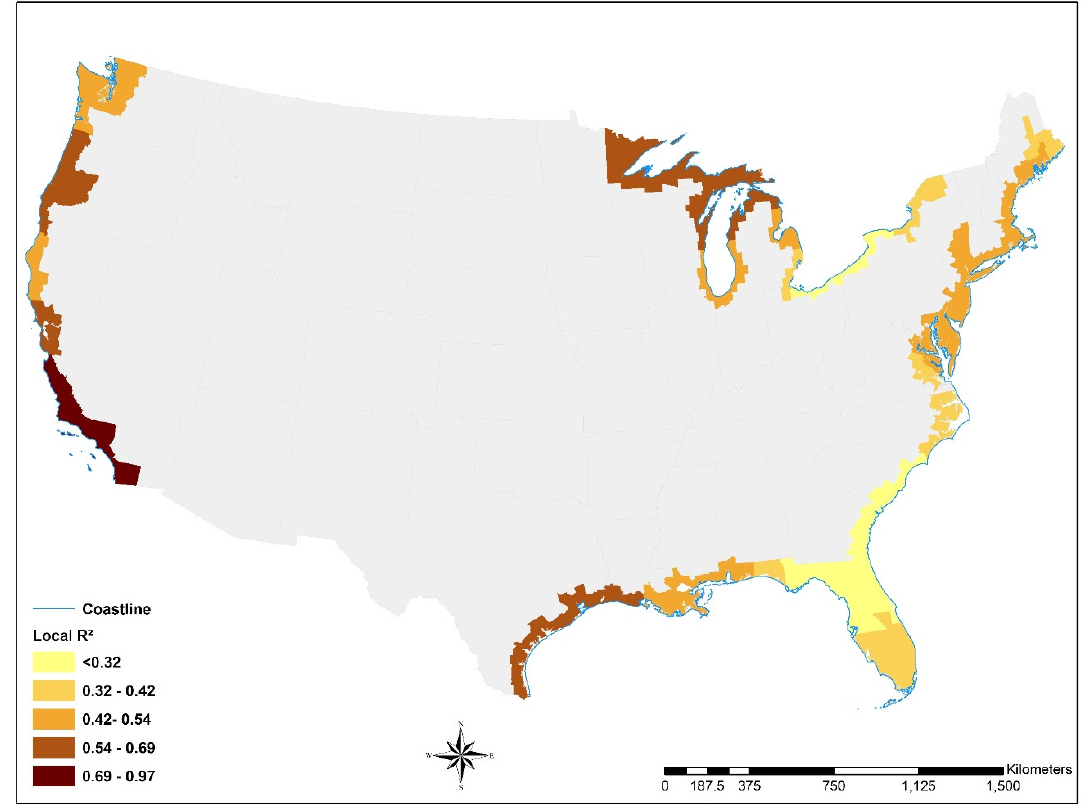
Figure 6. The spatial distribution of local R 2 values in the GWR model.